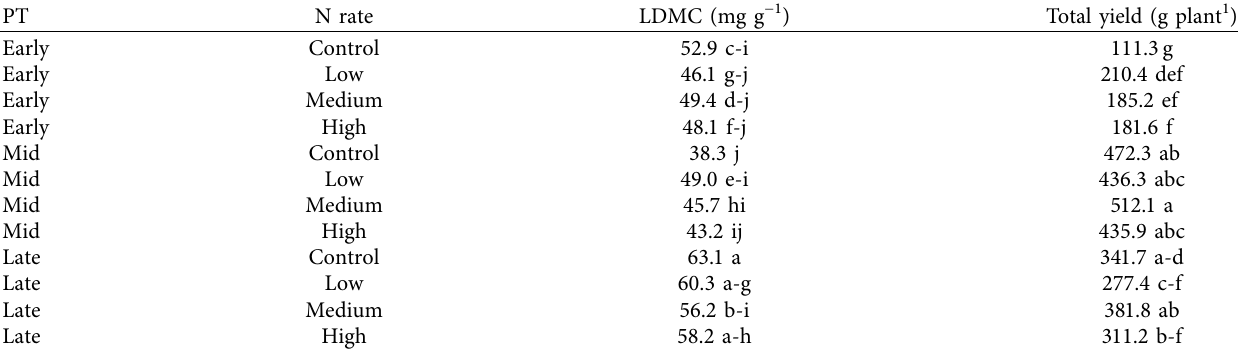
Table 5: Interaction effect of planting time (PT) and nitrogen (N) rate on leaf dry matter content (LDMC) and total yield. PT